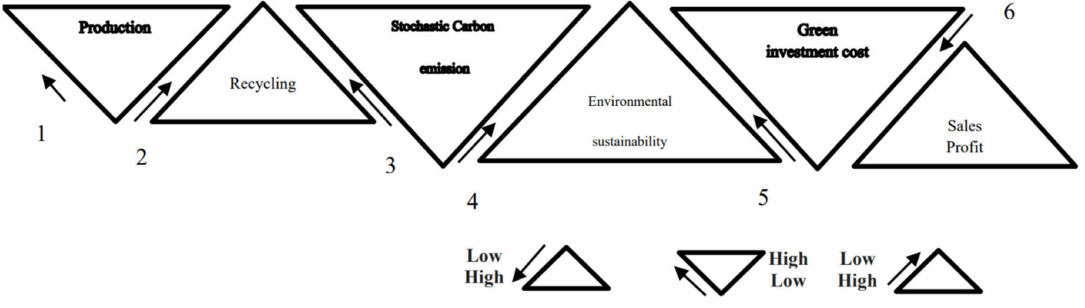
Figure 5. The six-pyramid model.